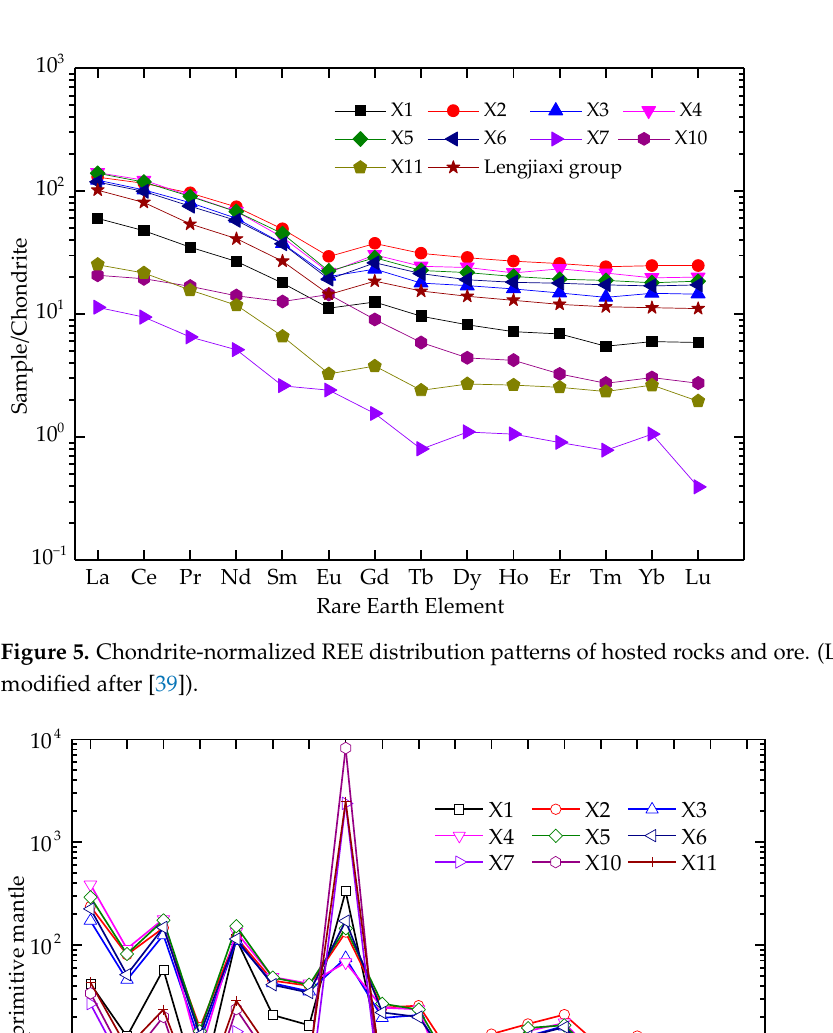
Table 3. Sulfur isotopic compositions of pyrite from Xiaojiashan gold deposit (‰). Sample